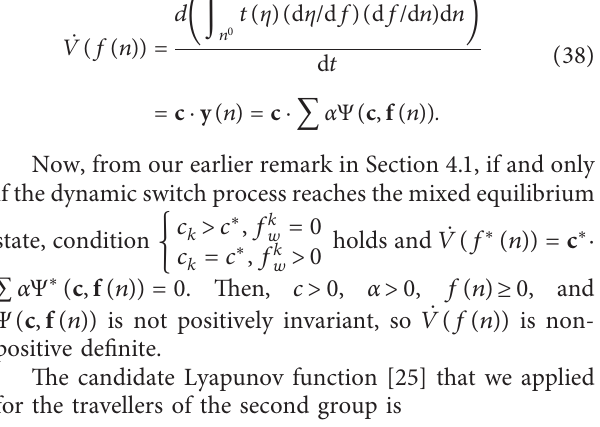
Figure 1: Test traffic network. Table 2: The parameters in the link travel time